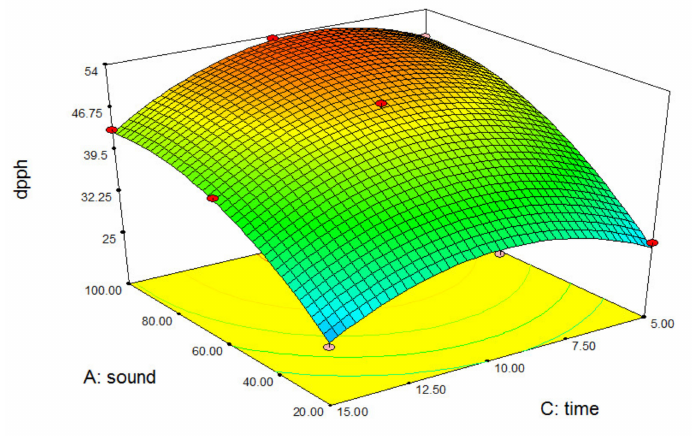
Figure 2. Response surface plot representing the effects of sound and time on diphenyl-1- picrylhydrazyl